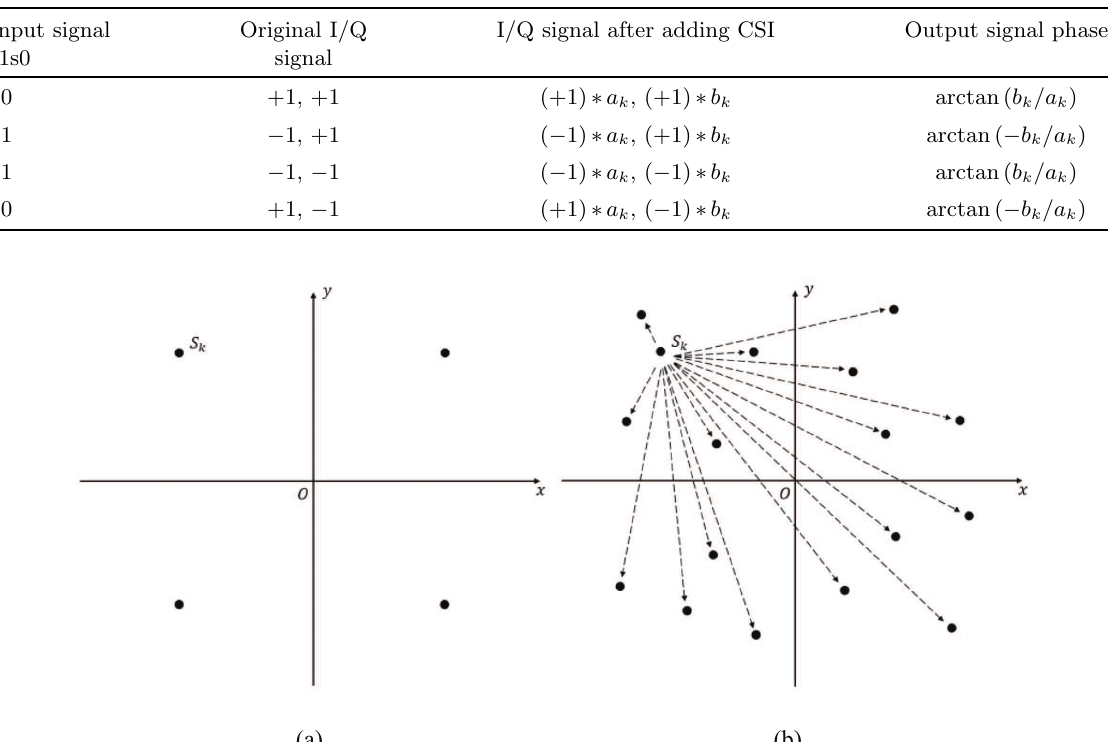
Table 1. Relationship between input signal, I/Q signal, and output signal phase after adding CSI